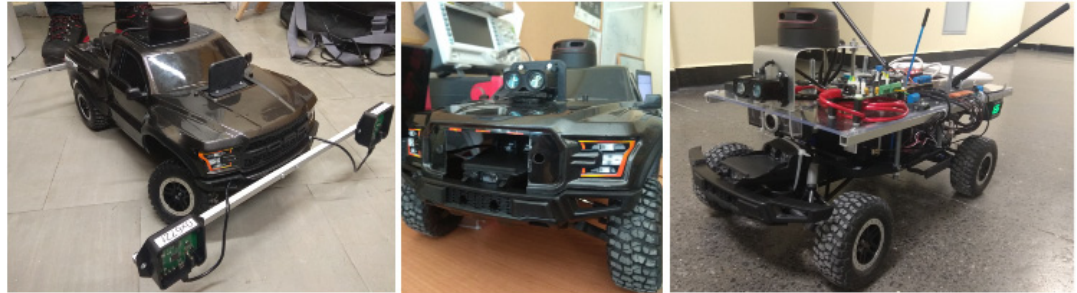
Figure 1. The evolution of the mobile platform used in tests.